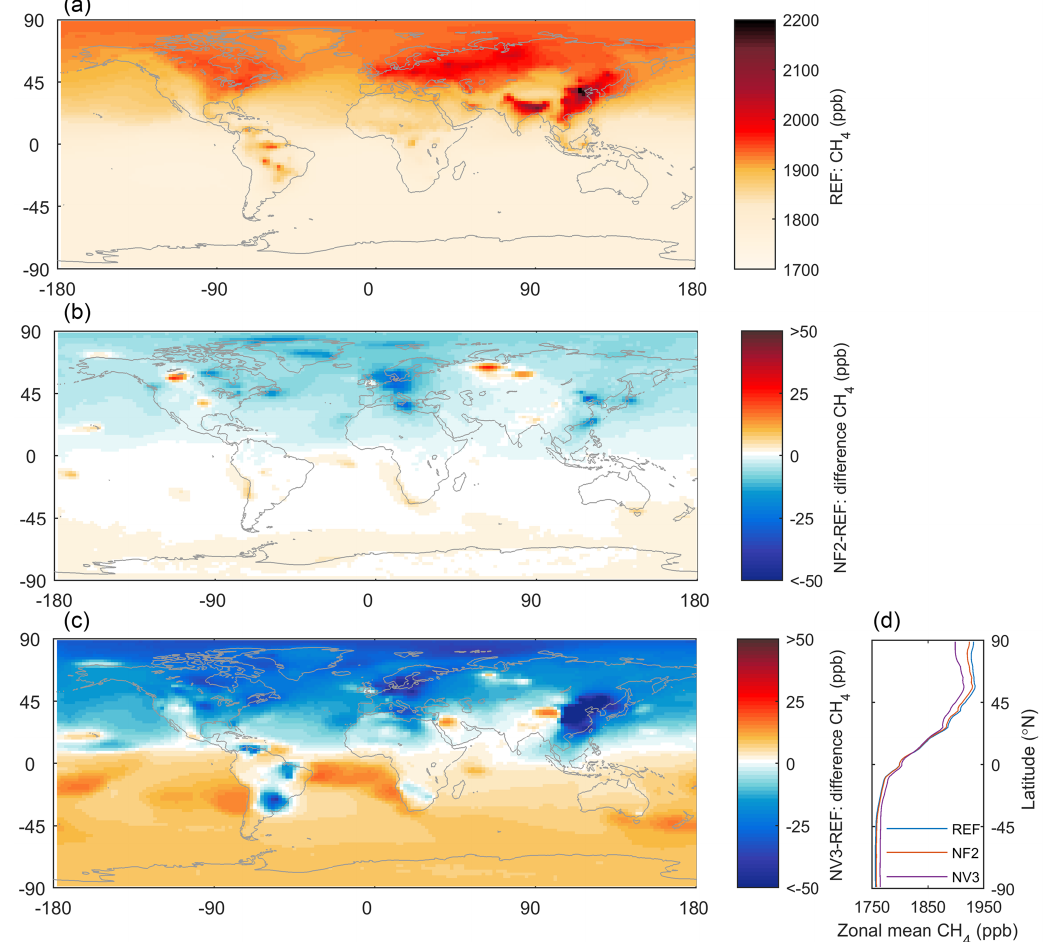
Figure 2. Simulated annual mean surface methane (ppb) for 2013 in the FLEXPART CTM reference simulation (a) and the difference in annual mean surface methane for FLEXPART CTM NF2 (b) and NV3 (c) compared to the reference simulation. Additionally, zonal averages of surface methane (ppb) for all three simulations are also shown (d)